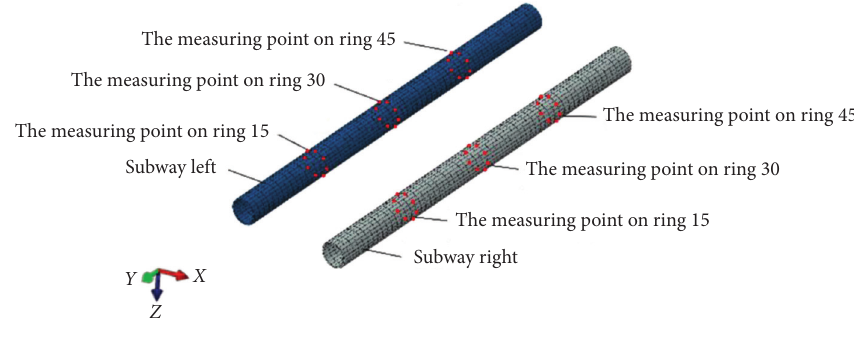
Figure 6: Monitoring cross-section